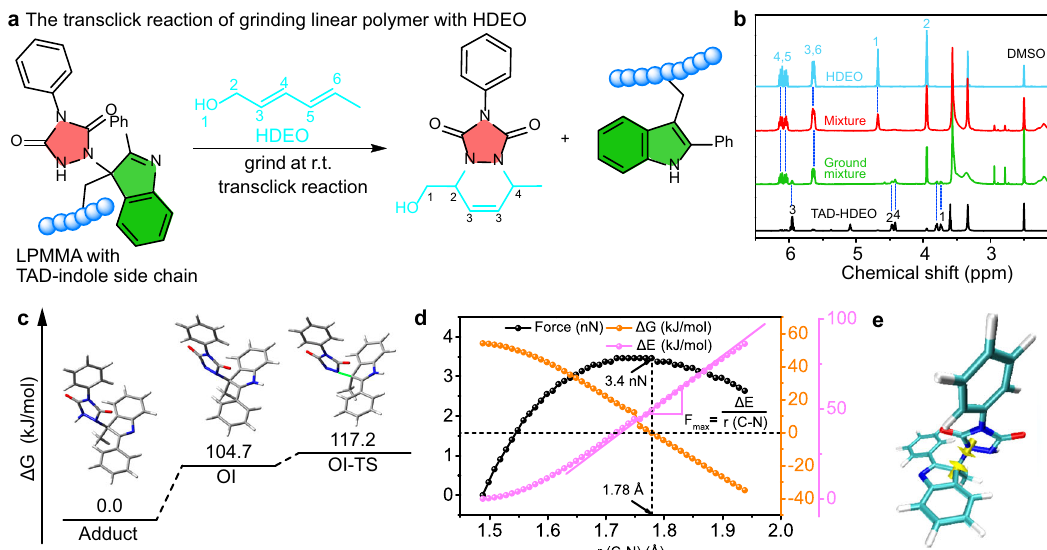
Fig. 2 Veri fi ed force-reversible C-N bond breaking in the dry-state polymer network. a Transclick reaction of TAD-indole side chain in LPMMA to an irreversible TAD-HDEO adduct, triggered by the external force at ambient temperature. b 1 H NMR spectrum of a small molecule HDEO (blue), the TAD- HDEO reference adduct (black), the mixture of HDEO and LPMMA with TAD-indole side chains (red) and the ground mixture (green) dissolved in DMSO- d 6 . c Free energy pro fi les (kJ/mol) for TAD-indole adduct, open zwitterionic intermediate (OI) and transition state (OI-TS). d Theoretically calculated restored force, free energy and potential energy of dissociation of TAD-indole adducts as a function of C-N bond length at 1 atm, 298.15 K. e TAD-indole adduct with yellow arrows along the C-N bond representing the loading direction of the C and N atom when external force is applied in the quantum- chemical